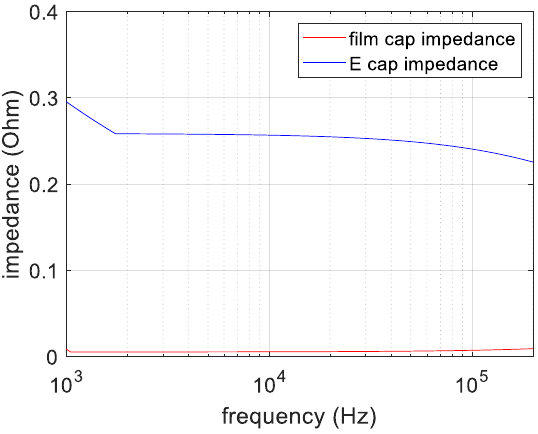
Figure 11. Frequency characteristics of impedance values of the electrolytic and film capacitors used in the DC capacitor of VSI in electric compressor systems.